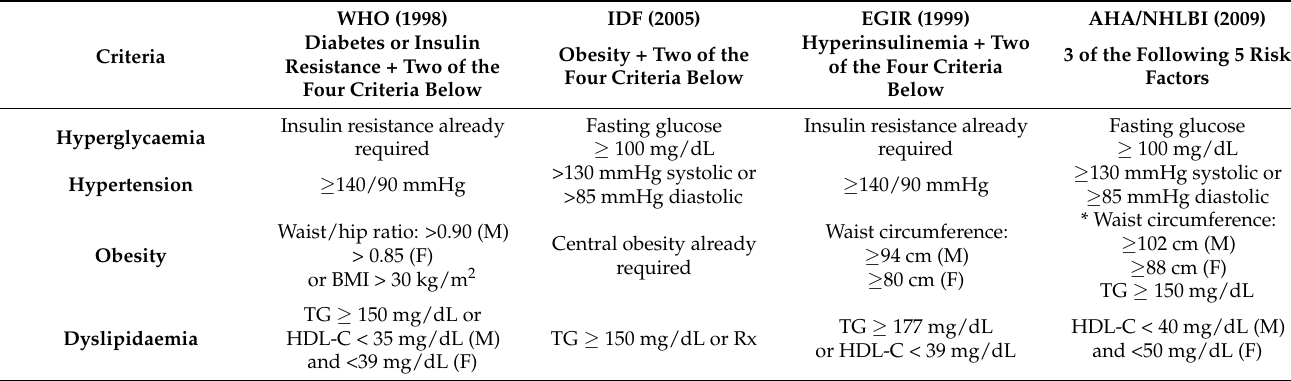
Table 2. Definitions and criteria for metabolic syndromes according to World Health Organization (WHO), European Group for the Study of Insulin Resistance (EGIR), International Diabetes Federation (IDF) and American Heart Associa- tion/National Heart, Lung, and Blood Institute (AHA/NHLBI). According to IDF, 25% of the total adult population of the world succumbs from metabolic syndrome. According to the National Health and Nutrition Examination Survey, the prevalence of metabolic syndrome is found to be 60% in obese individuals, 22% in overweight and 5% among normal weight individuals. * According to Alberti et al. (2009) [54], it is recommended that the IDF cut-off points be used for non-Europeans and either the IDF or AHA/NHLBI cut-off points be used for people of European origin until more data are available. HDL: high density lipoprotein, Rx: pharmacologic treatment, TG: triglycerides, BMI: body mass index; waist circumference in EGIR is for European men and